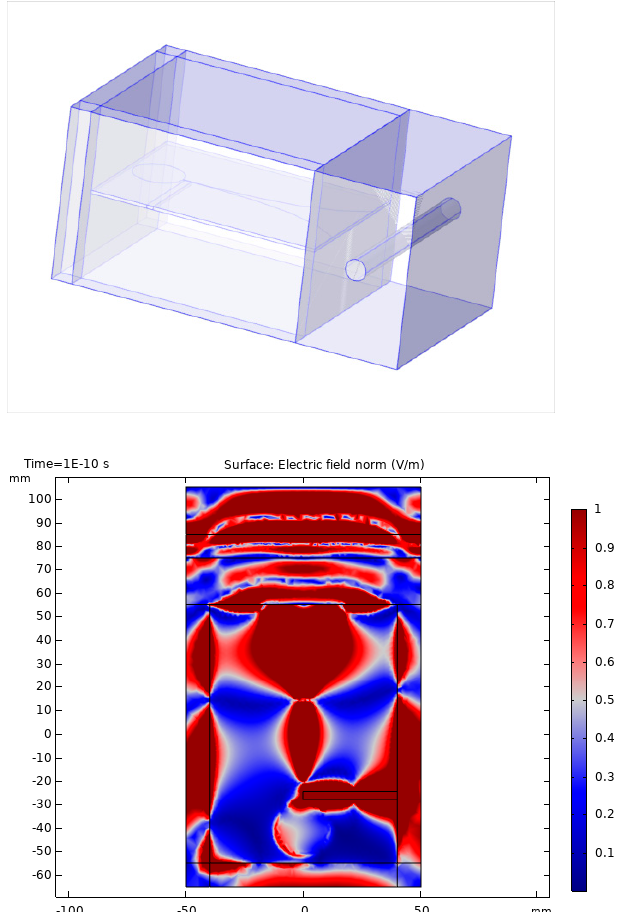
Figure 2. COMSOL simulation of microwave electromagnetic signals and reflection of the waves at borders in a macro scale. The left part is the antenna, and the right part shows the simple model with the artery in a salty water environment.